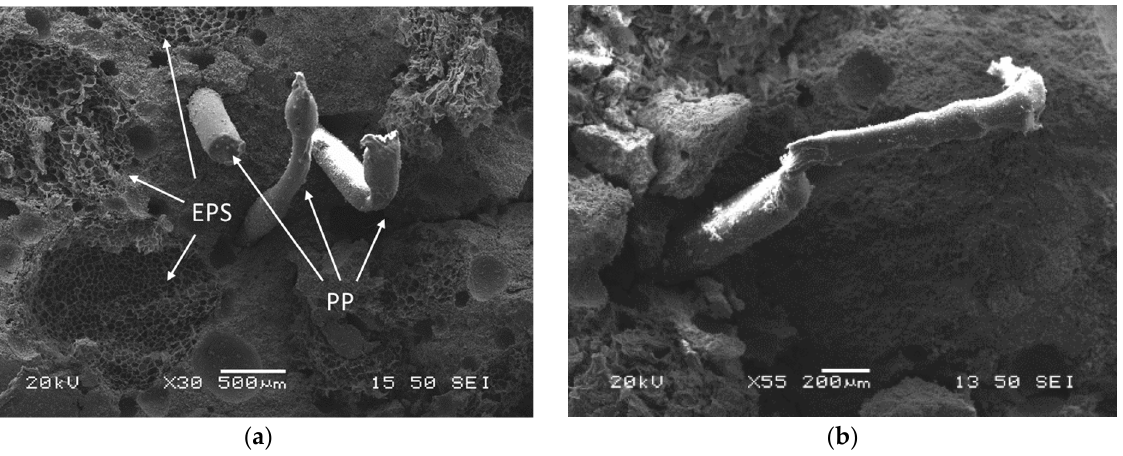
Figure 9. SEM images of fiber-reinforced matrix (3% wt. EPS and 0.5% wt. PP fibers) received at low ( a ) and high ( b ) magnification.